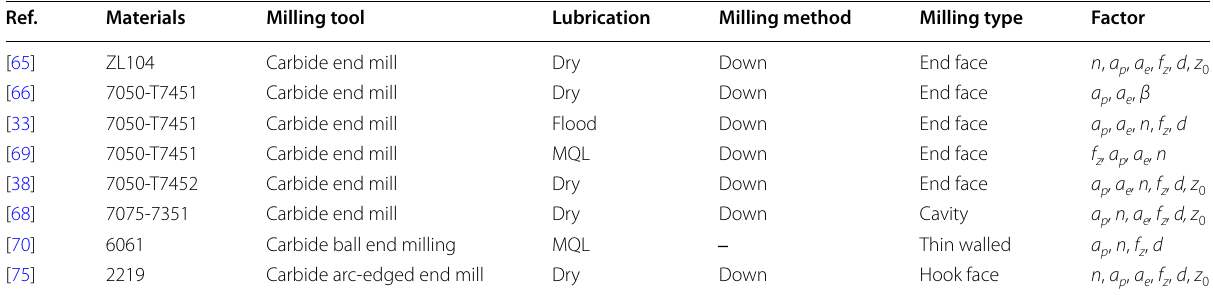
Table 1 Research on empirical model of milling force of aerospace aluminum alloy